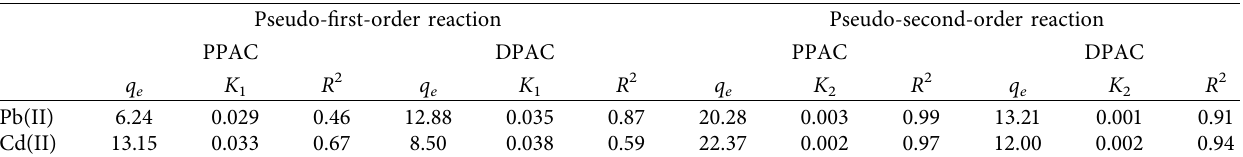
Table 5: Pseudo-first-order and pseudo-second-order reaction constants for adsorption of Pb(II) and Cd(II) onto the surface of PPAC and DPAC adsorbents.